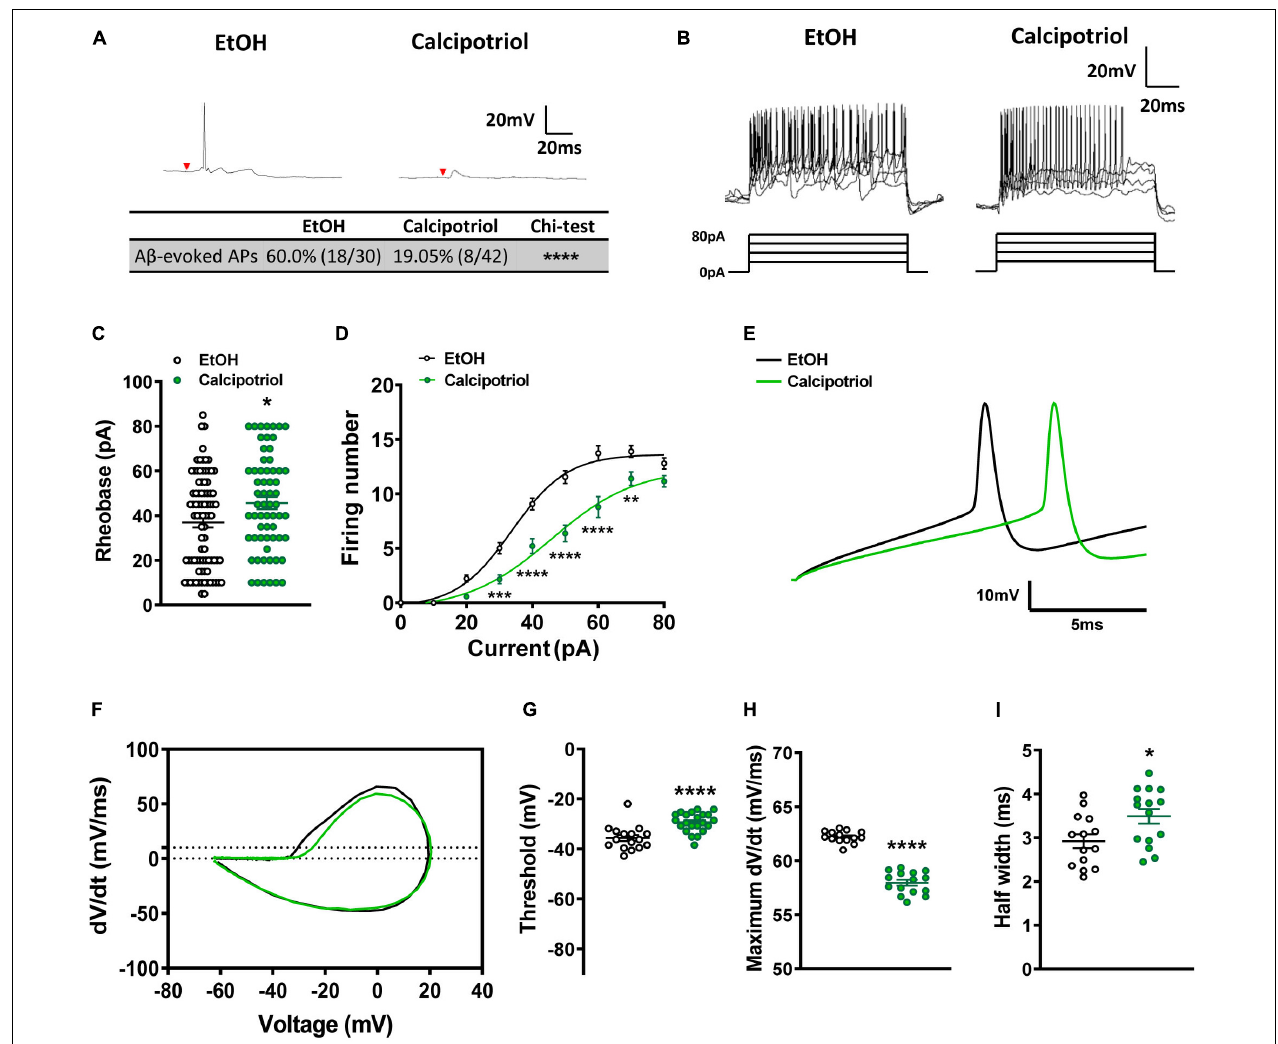
FIGURE 2 | Action potential properties in NPY + neurons. (A) A typical trace of A β -evoked action potentials (A β -eAPs) in the recorded NPY + neurons. These data included recordings from 30 neurons of EtOH-treated mice and 42 neurons of calcipotriol-treated NPY Cre ;Ai14 mice. (B) Firing properties of NPY + neurons in EtOH and calcipotriol-treated NPY Cre ;Ai14 mice. The majority of NPY + neurons display a tonic firing pattern upon current injection. (C) Average AP rheobase in control and chronic itch mice. Control, n = 86; chronic itch, n = 63. * p < 0.05. Student’s unpaired t -test. (D) Average AP firing numbers responding to depolarizing currents in control and chronic itch mice. Control, n = 38; chronic itch, n = 44, ** p < 0.01, *** p < 0.001, ****V < 0.0001. ANOVA test. (E) Single AP induction upon current injection in NPY + neurons in control and calcipotriol-treated chronic itch mice. (F) Phase plot (dV/dt vs. V) of the AP from (E) . (G) Average AP threshold in